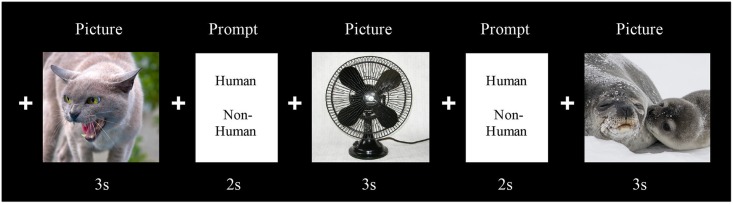
Experimental design of the event-related emotional processing task.Each trial started with a black screen with a white fixation cross, followed by a picture or null-event (fixation cross). After an inter-stimulus interval (fixation cross) a prompt appeared on the screen asking the participants whether the pictured contained a (part of a) human or not. The onsets of both the pictures and prompt were jittered in order to achieve optimal sampling of the hemodynamic response. Note that the pictures depicted in Fig 1 are not from the IAPS. In the actual experiment the words human/non-human were placed next to each other.